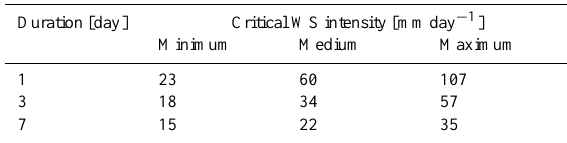
Table 2. Critical water supply (WS) intensity calculated from the absolute minimum, medium and maximum ID threshold over dura- tions of 1, 3 and 7 days.